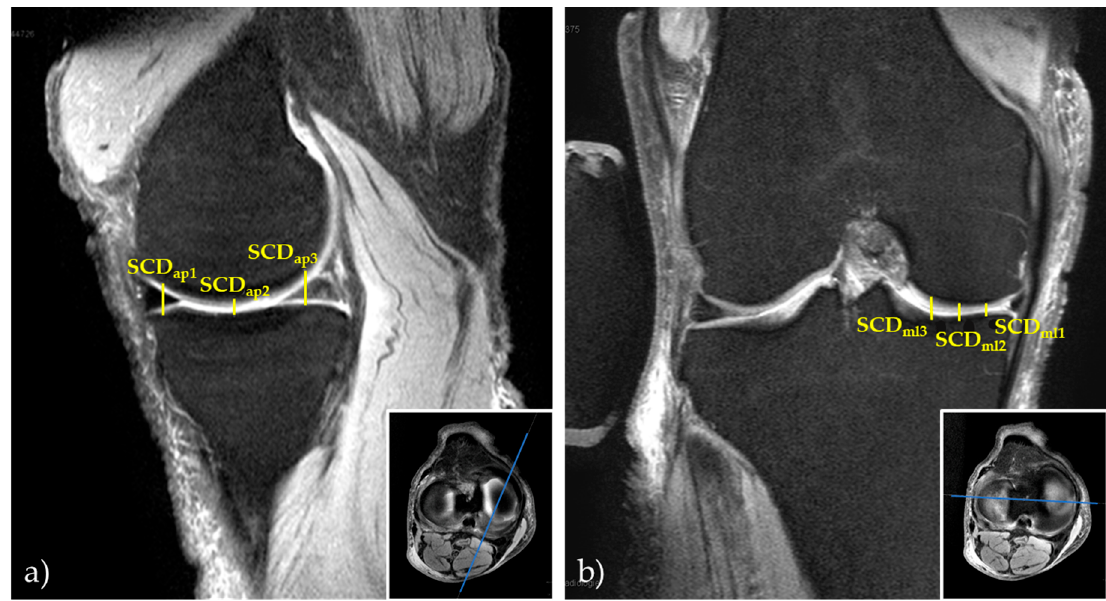
Figure 4. Example manual 2D reference measurements of subchondral cortical distances in the medial compartment. Visualized are the mid-sagittal ( a ) and mid-coronal ( b ) images of the Proton Density-weighted fat-saturated sequences and inset boxes to indicate their orientation. Subchondral cortical distances are indicated by yellow lines as the vertical distances between the femoral and tibial subchondral cortices at three locations along the anteroposterior (SCD ap1 to SCD ap3 [ a ]) and mediolateral dimensions (SCD ml1 to SCD ml3 [ b ]).